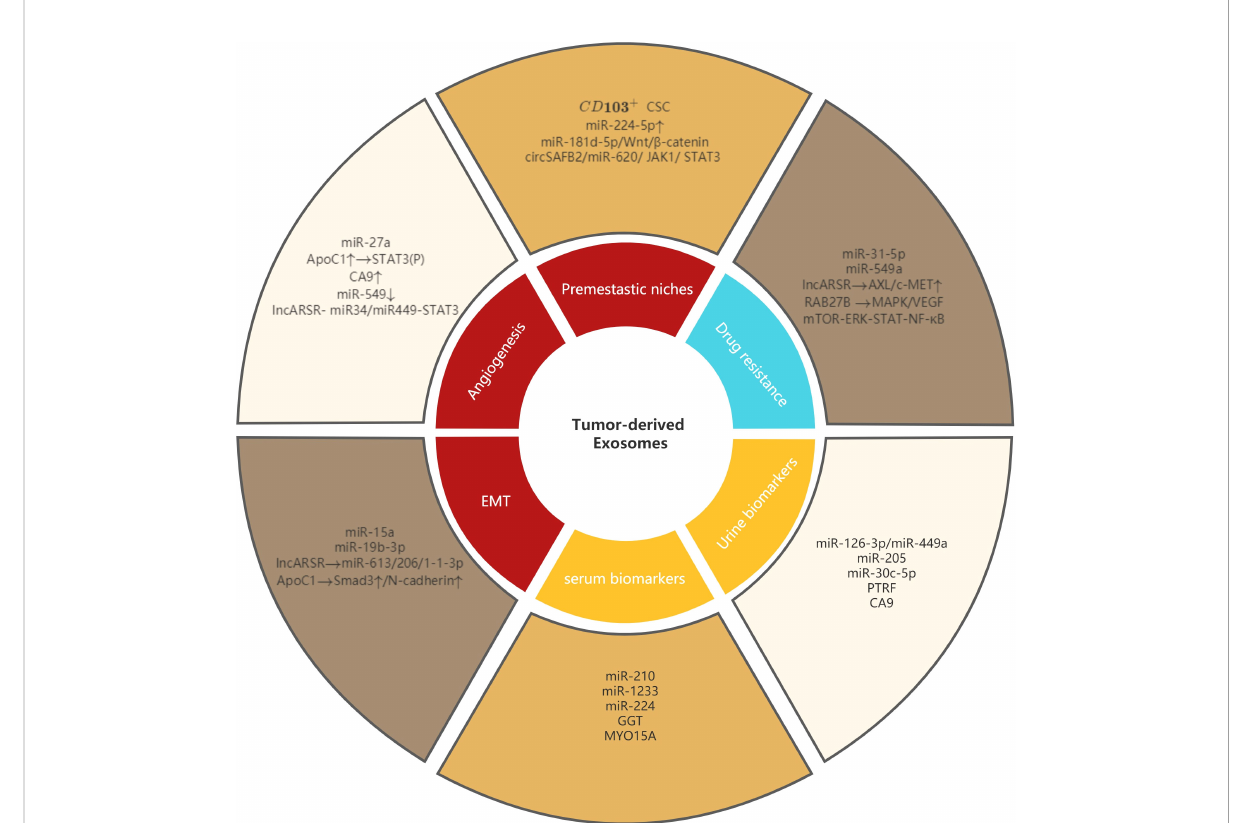
FIGURE 1 Role of tumor-derived exosomes in metastasis, diagnosis and drug resistance of ccRCC. Tumor-derived exosomes involved in premetastatic niches, angiogenesis, EMT and drug resistance of ccRCC. Tumor-derived exosomes can also be used as serum biomarkers and urine biomarkers in